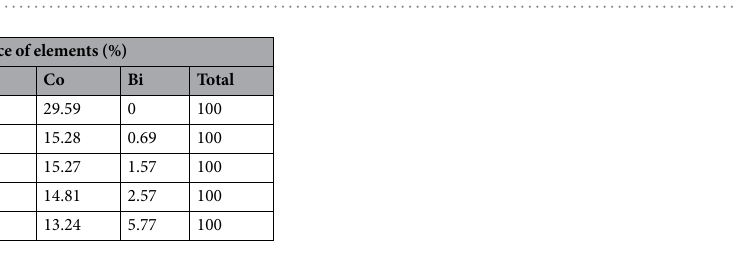
Figure 4. The SEM images of CBF with; ( a ) x = 0.0, ( b ) x = 0.05, ( c ) x = 0.10, ( d ) x = 0.15, ( e ) x = 0.20 and ( g ) EDS (when x = 0.20).